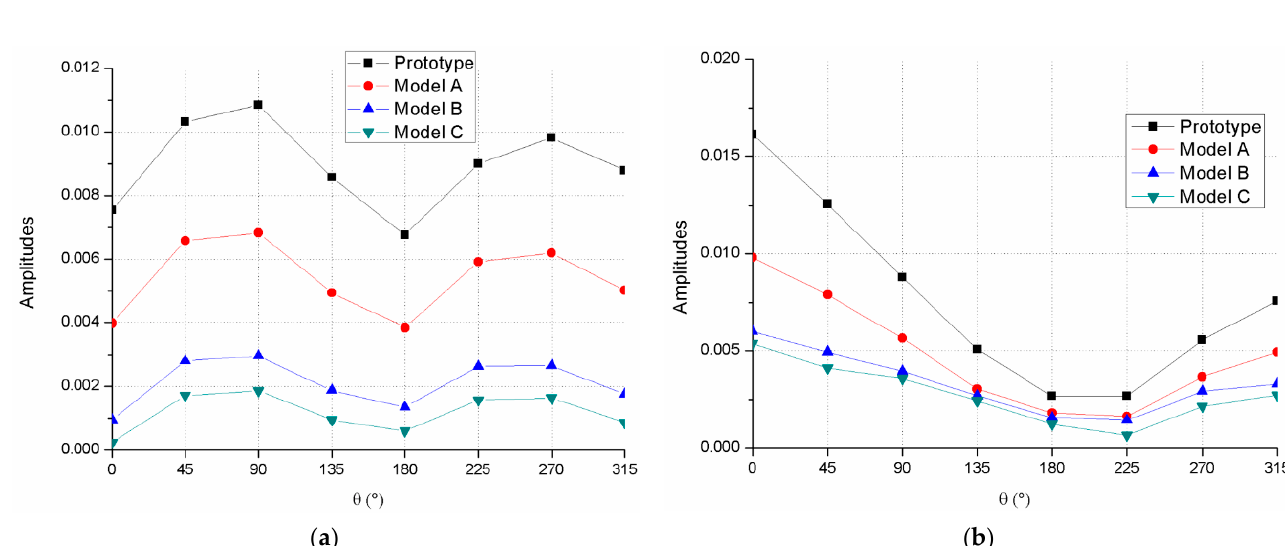
Figure 7. Comparison of spectra amplitudes at ( a ) 𝑓 (cid:3003)(cid:3017)(cid:3007) ; ( b ) 0.5 𝑓 (cid:3003)(cid:3017)(cid:3007) .